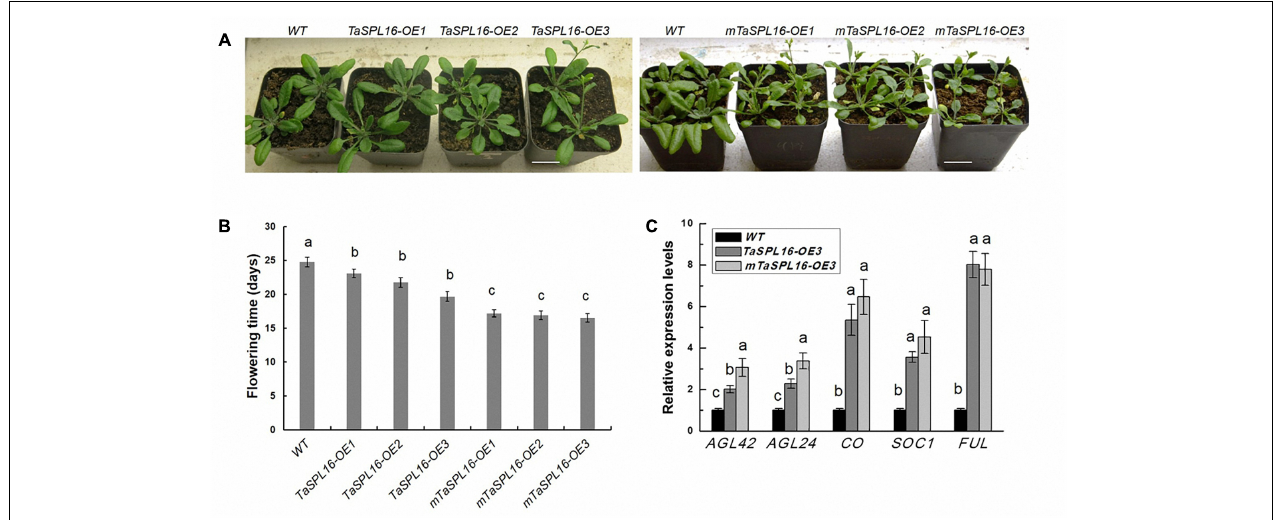
FIGURE 5 | Overexpression of TaSPL16 promotes early flowering in Arabidopsis . WT, wild-type Arabidopsis ; TaSPL16-OEs , transgenic lines expressing non-mutated TaSPL16-7B ; mTaSPL16-OEs , transgenic lines expressing miR156-resistance mRNA of TaSPL16-7B . (A) Phenotypes of wild-type and homozygous transgenic lines at three week old. Scale bar: 2 cm. (B) Comparison of flowering time of wild-type and transgenic lines. Flowering time of Arabidopsis plant is accounted by scoring bolting days (from sowing to the primary inflorescence reaching a height of 0.5 cm). (C) Relative expression levels of known flowering-related genes in wild-type and transgenic lines. TaSPL16-OE3 and mTaSPL16-OE3 are shown as representatives, because similar phenotypes were observed among independent mTaSPL16-OEs or TaSPL16-OEs . The value of each column represents mean ± SD ( n = 10). Different letters at top of each column indicate a significant difference among genotypes at P < 0.05 determined by Tukey’s HSD